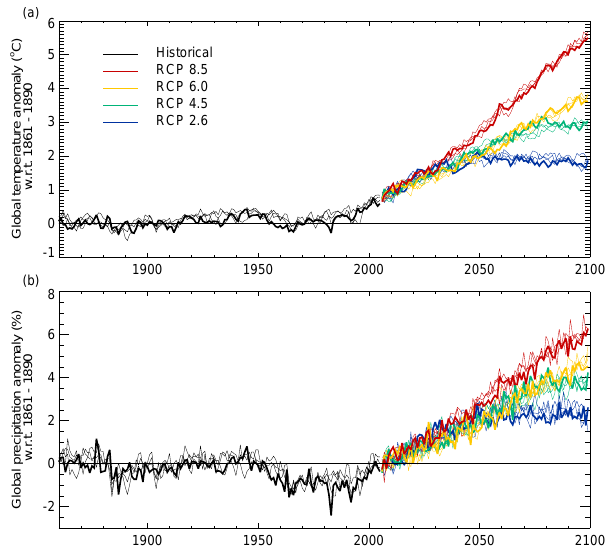
Figure 4. Global annual mean (a) temperature and (b) precipitation changes simulated by HadGEM2-ES in RCP 2.6 (blue), 4.5 (cyan), 6.0 (yellow) and 8.5 (red). Thick lines show the simulations used in the analysis here. Thin lines show additional simulations performed with the same model and same forcing scenarios but slightly differ- ent initial conditions, in order to illustrate the magnitude of naturally occurring internal variability in the